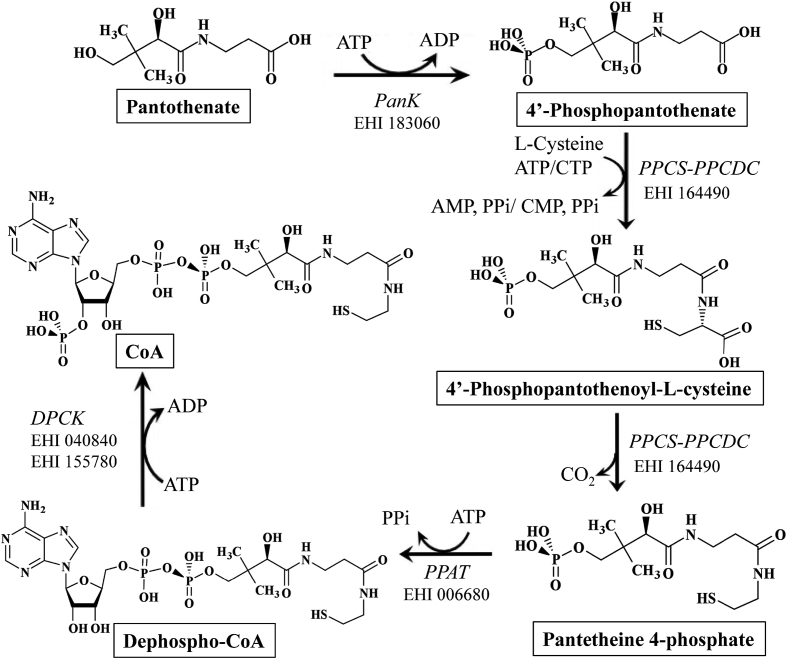
Coenzyme A biosynthetic pathway in E. histolytica. ID numbers of individual enzymes in AmoebaDB are also shown. PanK, pantothenate kinase; PPCS-PPCDC, bifunctional phosphopantothenoylcysteine synthetase and phosphopantothenoylcysteine decarboxylase; PPAT, phosphopantetheine adenylyltransferase; and DPCK, dephosphocoenzyme A kinase.